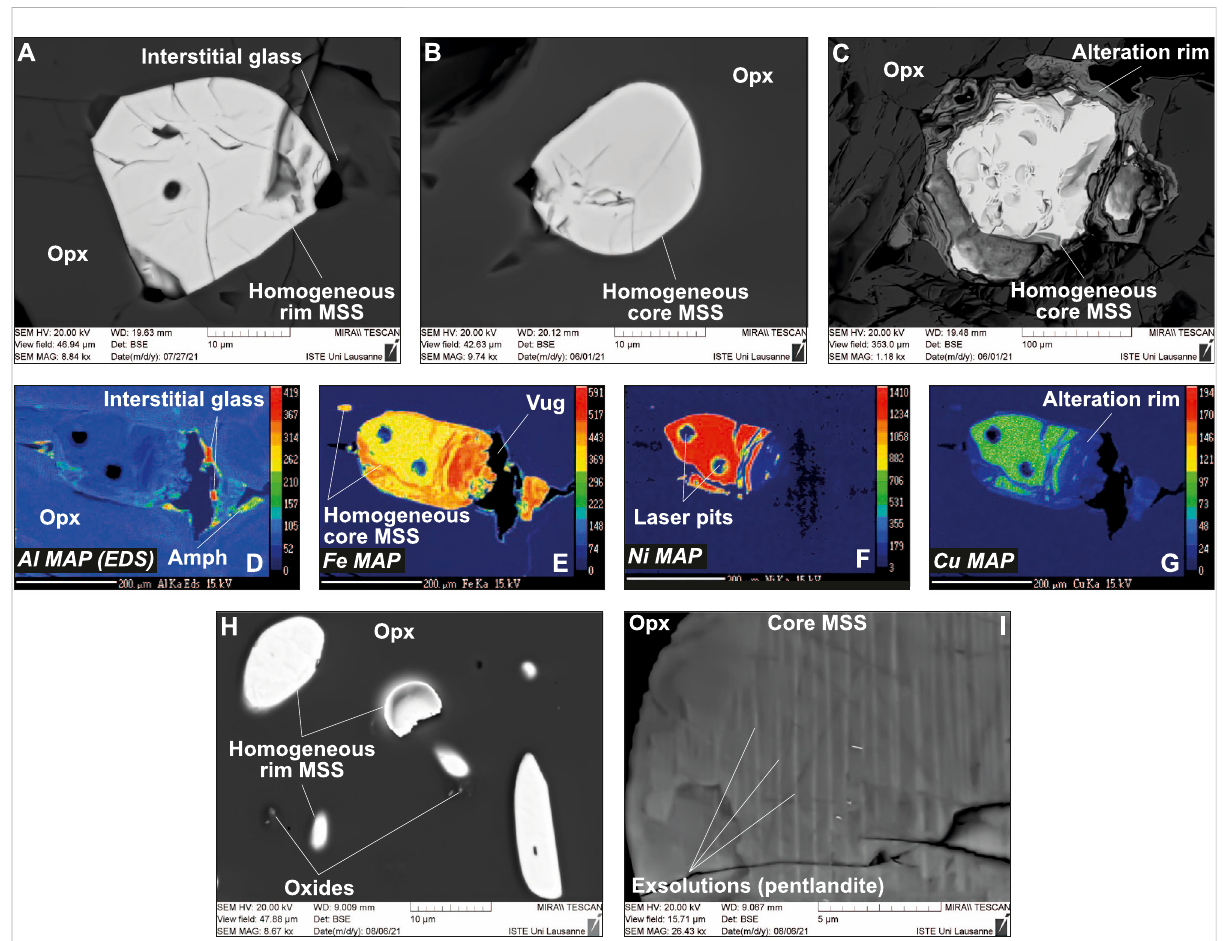
FIGURE 3 Textural features of sul fi des (all MSS) in Kamchatka Type 1A veins. (A – C) BSE images (SEM) and (D – G) major element maps (EPMA) for sul fi des either located atrimsorcoresoftheglass-bearingvein(sampleAv55). (H,I) BSE images (SEM)for sul fi des either located atrimsor cores oftheglass- free vein (sample Av20). Scale bar is 200 μ m in (D – G) , whereas the elements mapped are indicated in the bottom left corners of the images. Small oxidesappearassociatedwithrimsul fi desintheglass-freeveinfromKamchatkain (H) .NotethehomogeneityofMSSinallKamchatkasamples, except for pentlandite exsolutions in core sul fi des from the glass-free sample in (I) (see Bénard et al., 2011 for an earlier identi fi cation of this